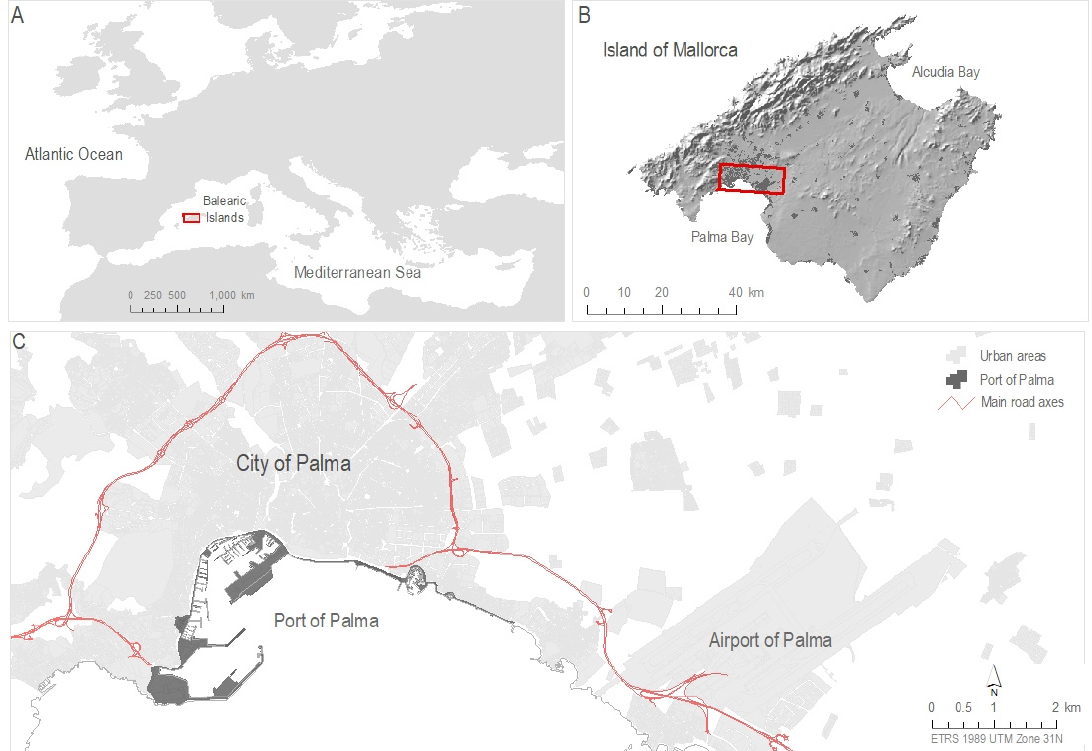
Figure 1. Location of the Port of Palma in ( A ) the western Mediterranean, ( B ) the island of Mallorca and ( C ) the city of Palma and its connection with the airport.